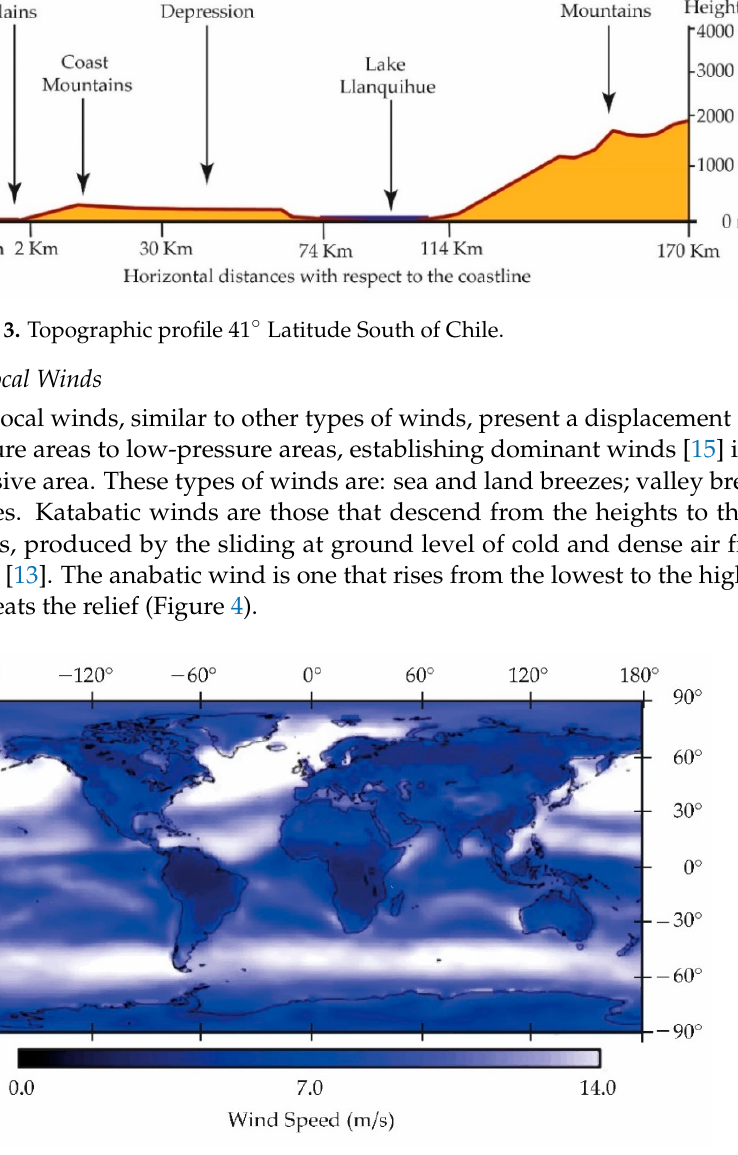
Figure 4. Annual wind speed at 10 m for airport-like terrain. July 1983–June 1993. (Public archive, NASA/SSE, 13 September 2004). The figure shows the zone of equatorial calms and, to the south, the belt of strong subantarctic katabatic winds.